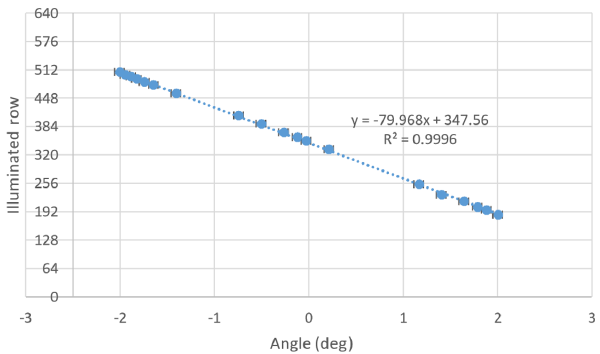
Figure 4. SHOW measured vertical